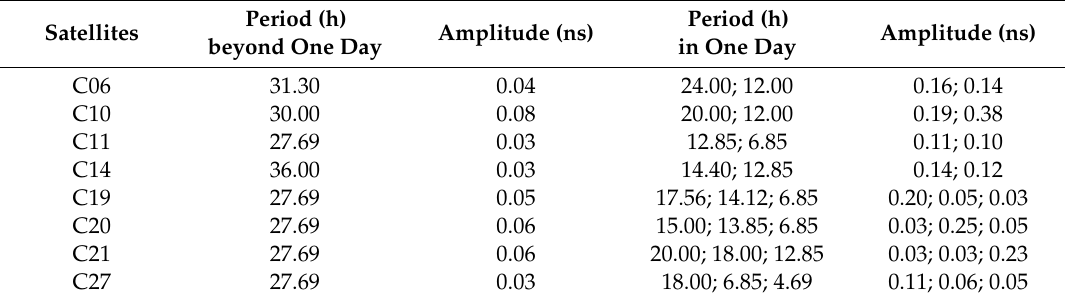
Table 1. Period and amplitudes of eight BDS satellites clock o ff sets beyond one day and in one day. Period Satellites